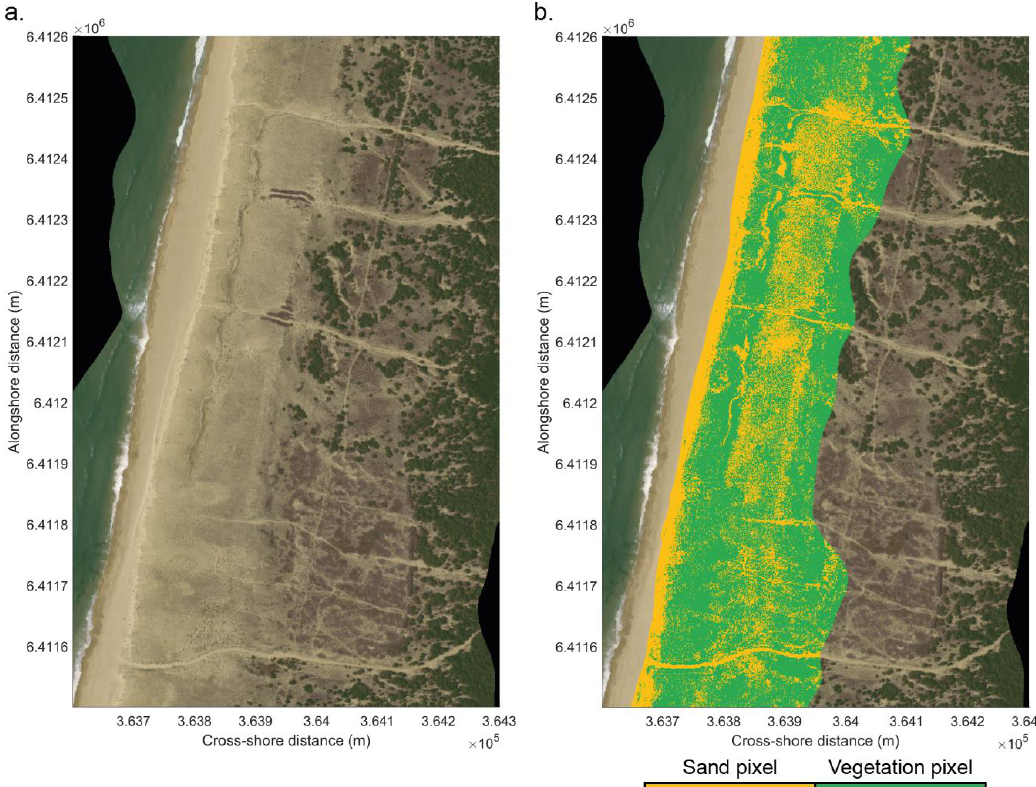
Figure A2. ( a ) Color orthophoto generated by airborne data and ( b ) result of the classification based on NDVI filter to discriminate sand and vegetation covers. The pixels at the western position of the beach—incipient foredune limit and the pixels at the eastern position of the iso contour z = 12 m have been filtered beforehand.